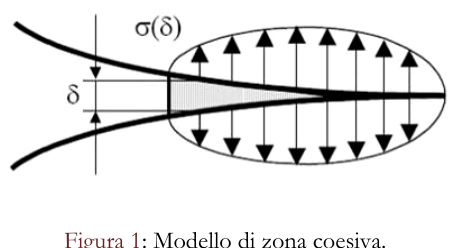
Figura 1: Modello di zona coesiva.